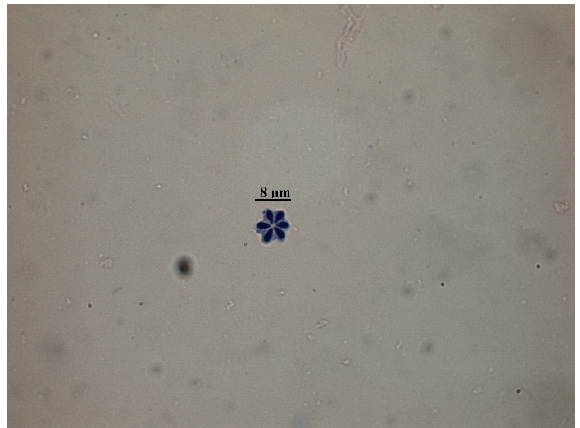
Figure 1. Morphological observation of Kudoa hexapunctata by muscle biopsy of Pacific bluefin tuna ( Thunnus orientalis ) cultured in South Korea. Scale bar = 8 µ